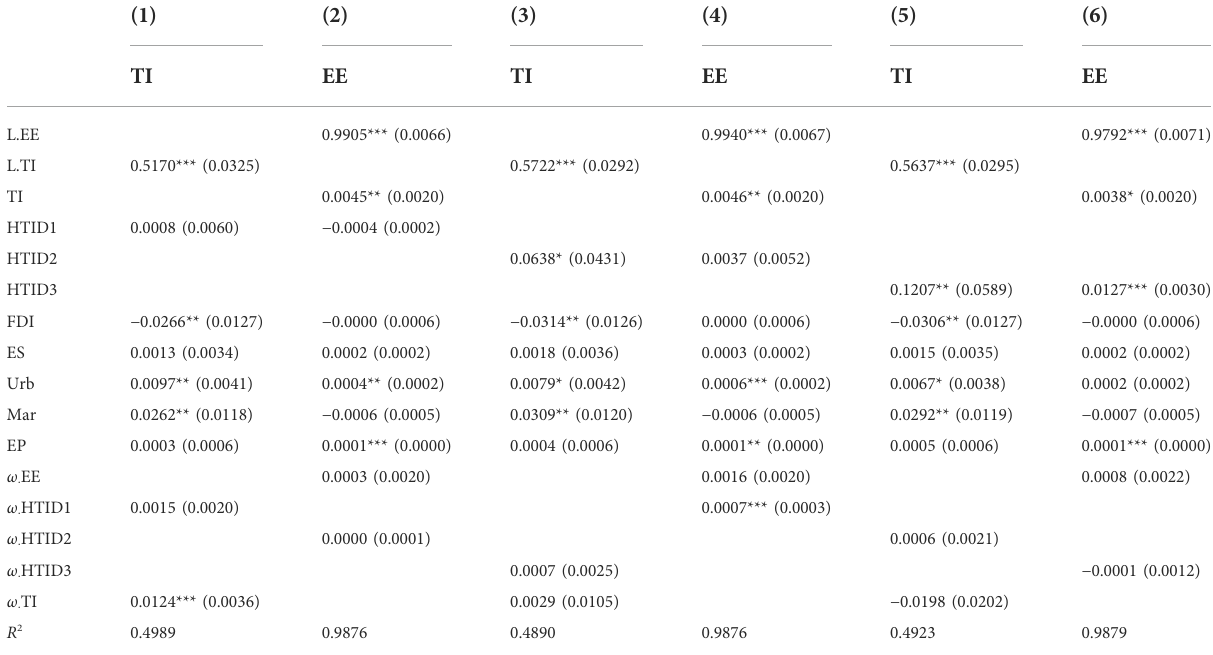
TABLE 7 Robust test of the intermediary effect of technological innovation.